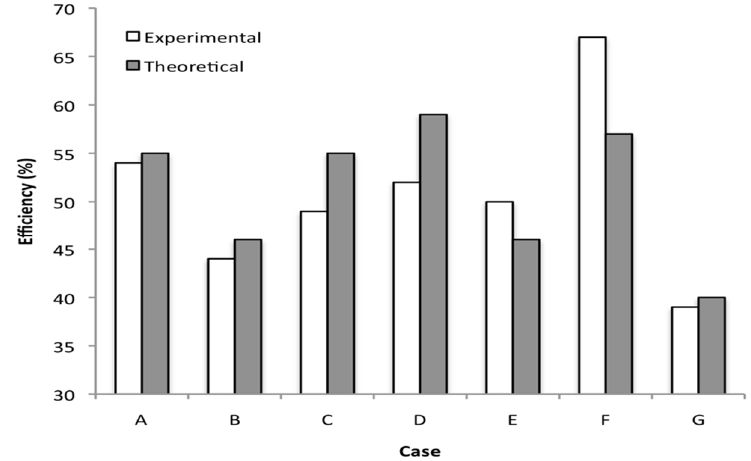
Figure 14. Comparison between the experimental and theoretical results for different cage armour systems and different impact conditions (note: configurations E and F have a very limited number of tests and the statistical value of the data is limited).